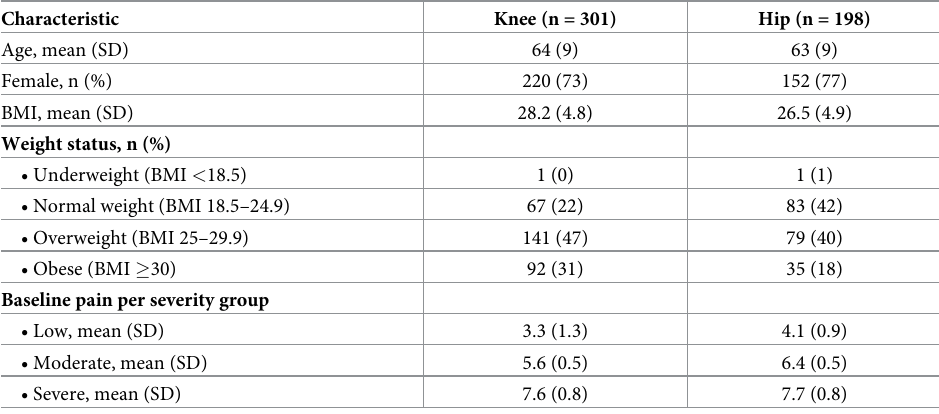
Table 1. Descriptive data for knee and hip OA in the 24-week sub-sample (n = 499). Characteristic